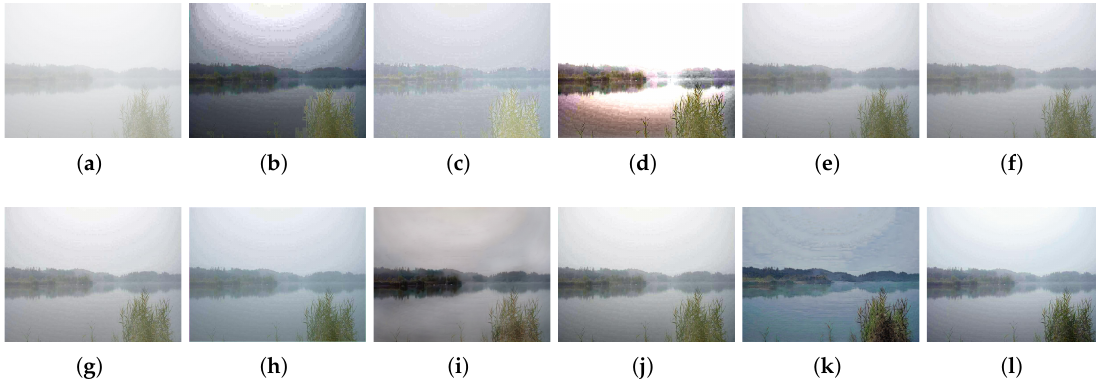
Figure 8. Real heavy hazy images and corresponding dehazing results from several state-of-the-art methods (best viewed in color). ( a ) Hazy Image. ( b ) Dark-channel prior (DCP). ( c ) FVR. ( d ) BCCR. ( e ) Color attenuation prior (CAP). ( f ) DehazeNet. ( g ) MSCNN. ( h ) AOD-Net. ( i ) dehaze-cGAN ( j ) Proximal. ( k ) CycleGAN. ( l )